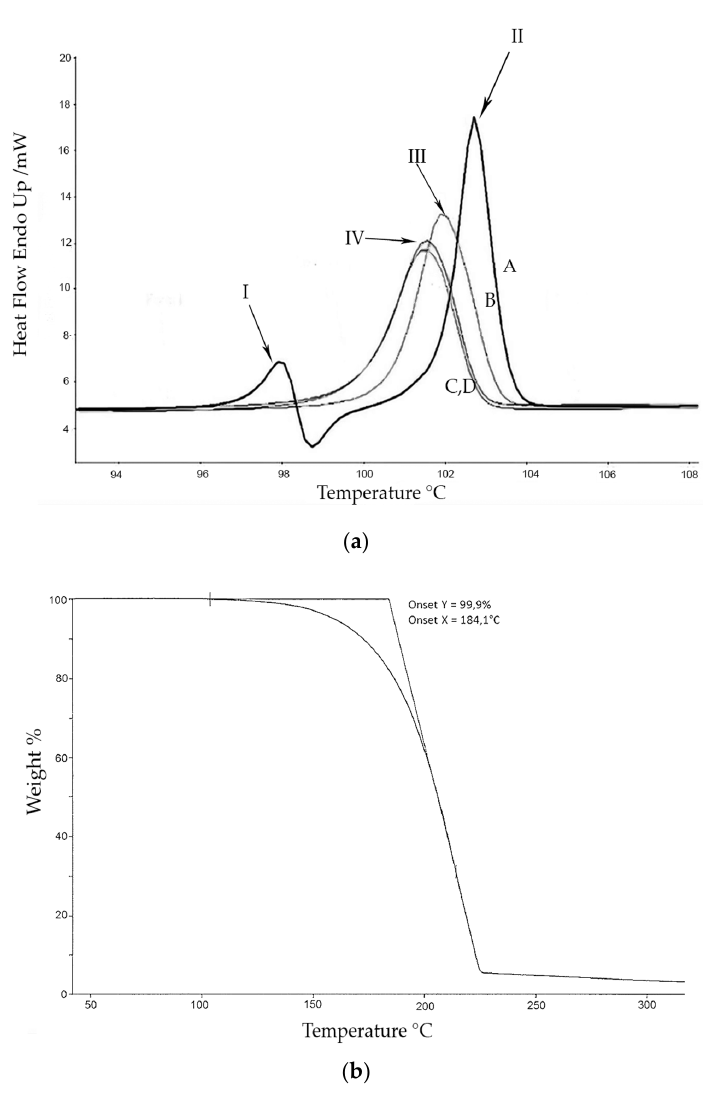
Figure 2. DSC and TG of compound VA6E ( a , b ) respectively. ( a ) Curve A: first scan (fusion Form I and Form II); curve B: second scan (fusion of Form III) and curves C and D: third and fourth scan (fusion of Form IV); ( b ) TG of compound VA6E at 10 °C/min. Table 2. Fusion–recrystallization of compound VA6E.